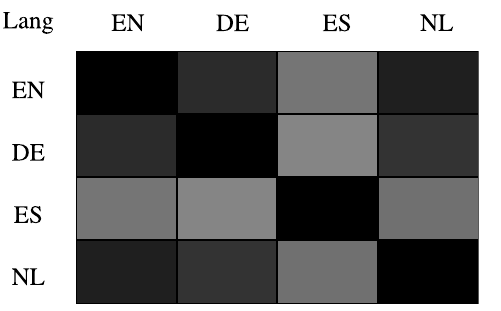
Fig 5. The similarity heatmap of language embeddings for different language pairs, where deeper color indicates higher similarity.